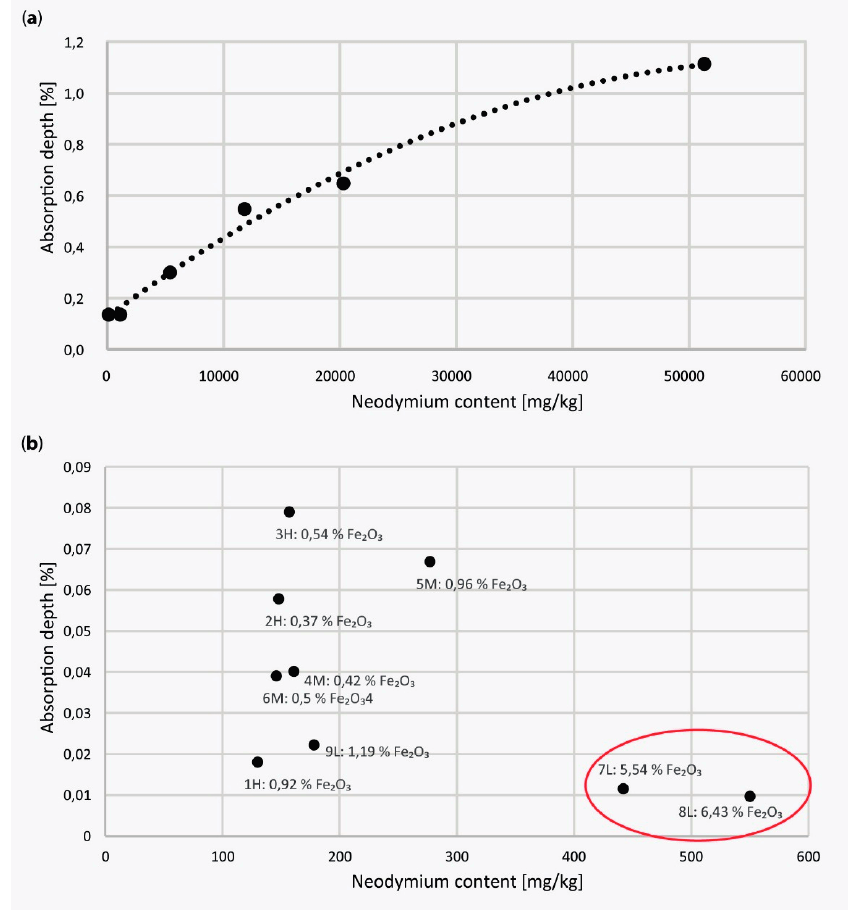
Figure 12. Quantitative comparison between the neodymium concentrations of mixture samples and field samples and the corresponding hyperspectral recordings. ( a ) Correlation between the amount of neodymium oxide within a calcium carbonate powder and the absorption depth of the 803 nm absorption band measured with the HySpex spectrometer in the laboratory. The trend line is a second-degree polynomial fit. ( b ) Correlation of the REE content of the field-samples with the depths of the neodymium absorption band measured with the ASD field spectrometer in the laboratory. Only samples 7L and 8L occur as outliers. This result is due to the iron oxide content, which is shown for all field samples as index numbers next to the plotted points in graph